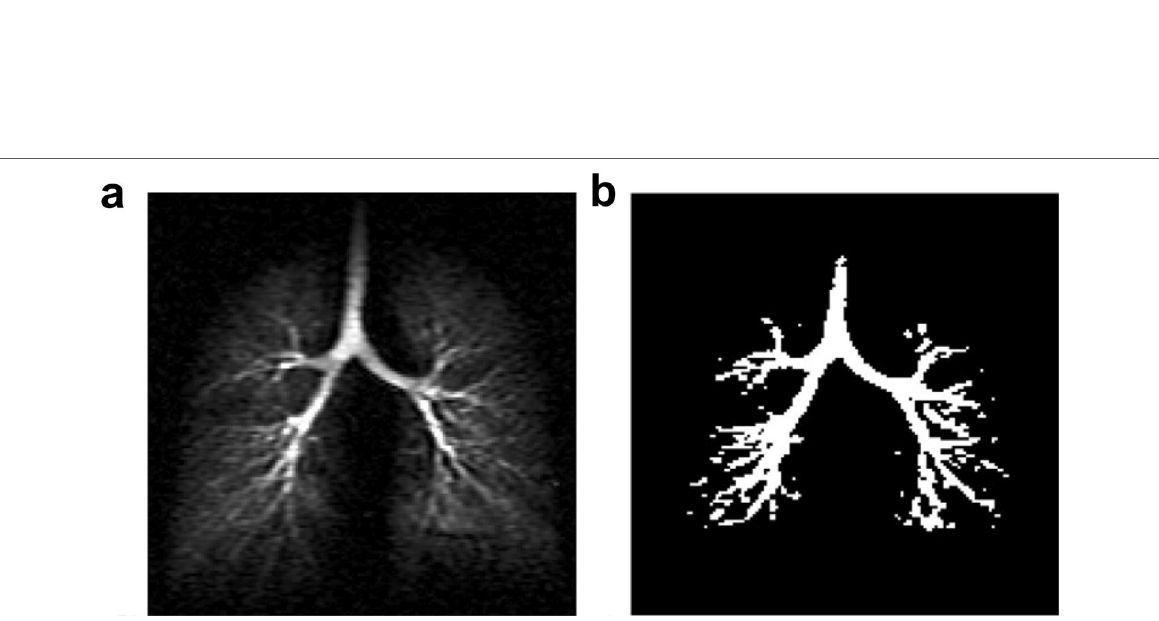
Fig. 9 Representative dynamic coronal MR images using hyperpolarized 3He MRI. Thresholding a dynamic projection image. a Before thresholding; b After thresholding. Reproduced with permission from John Wiley and Sons (License Number: 532430065345). Reproduced with permission from John Wiley and Sons (License Number: 5324291003853). NMR Biomed. 2013 April; 26(4):